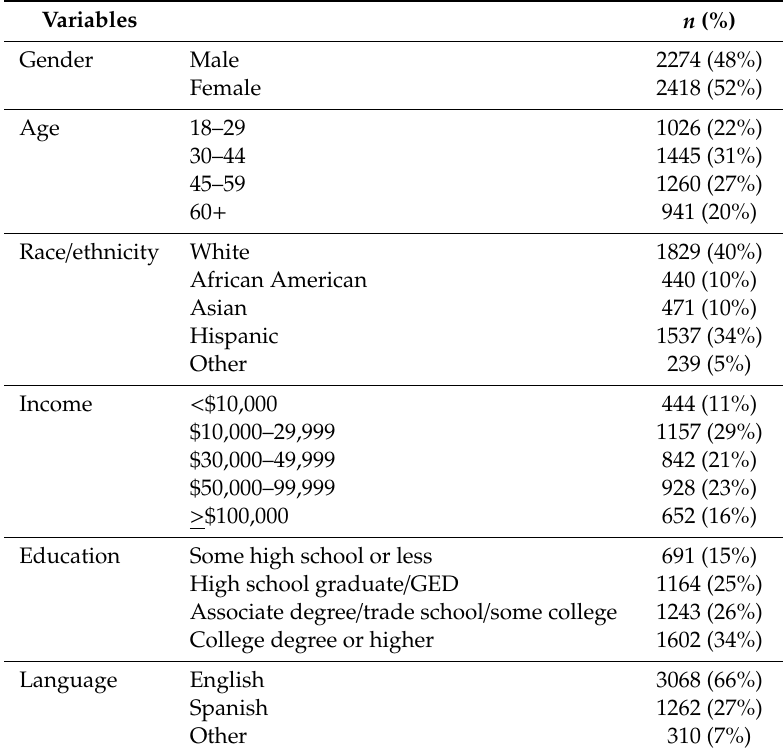
Table 1. Sample characteristics of respondents after weighting, Public Health Response to Emergent Threats Survey, 2013 ( n =